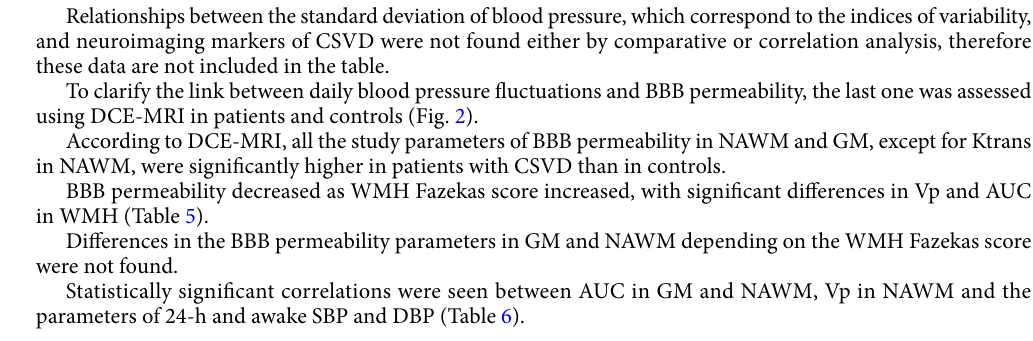
Table 3. ABPM results in subjects with CSVD and controls. Significant values are in